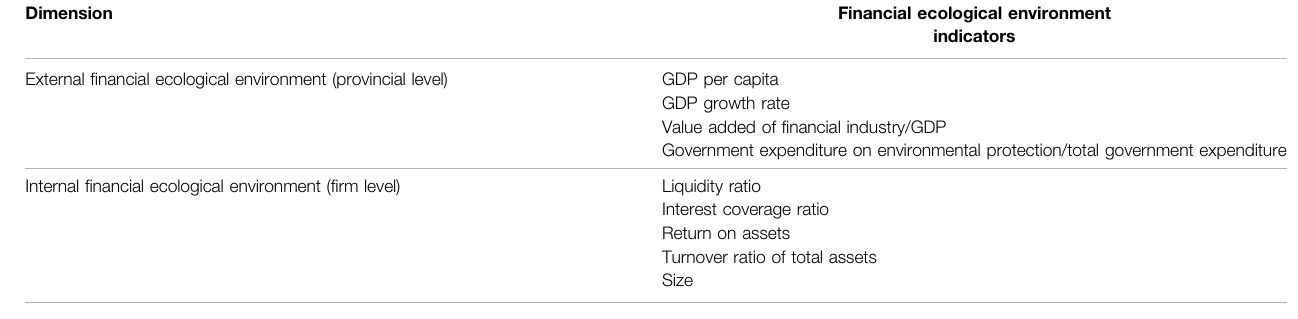
TABLE 1 | Indicators used to construct the fi nancial ecological environment index. Dimension